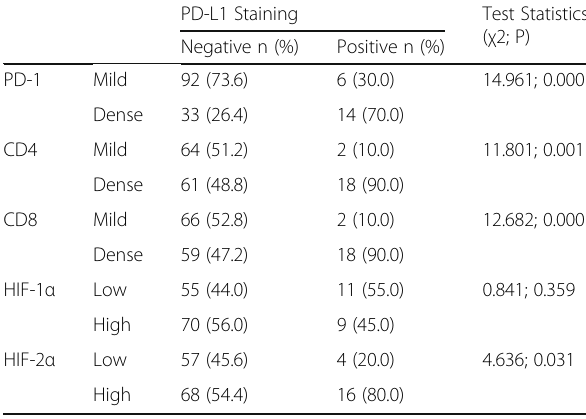
Table 2 PD-1, CD4, CD8, HIF-1 α , and HIF-2 α expression according to PD-L1 results PD-L1